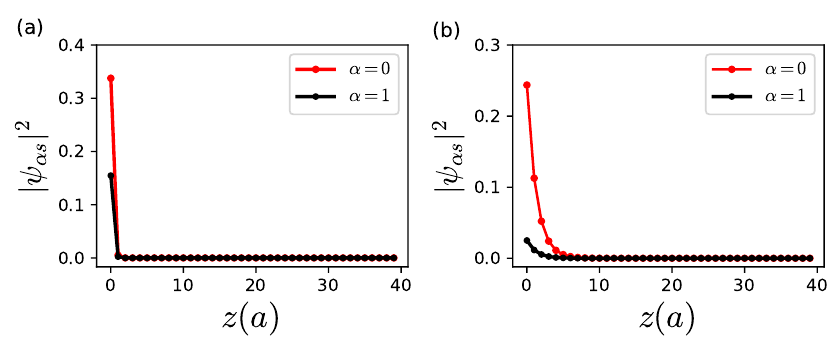
Figure 13: Eigenstate plots of the right moving Fermi arc surface states in the pres- ence of a finite commensurate field ( B (cid:54) = 0) with q = 2, for a finite slab along the = 40. Here α = 0,1 refer to the coordinate of the lat- z -direction with lattice sites L z tice sites inside the magnetic unit cell. (a) This is in the LCI phase: the right moving Fermi arc states are localized on the bottom surface z = 0 and both the pseudospin components have the same amplitude. (b) This is in the W2 phase: the right moving Fermi arc states are localized at the bottom surface z = 0 and both the pseudospin components have the same